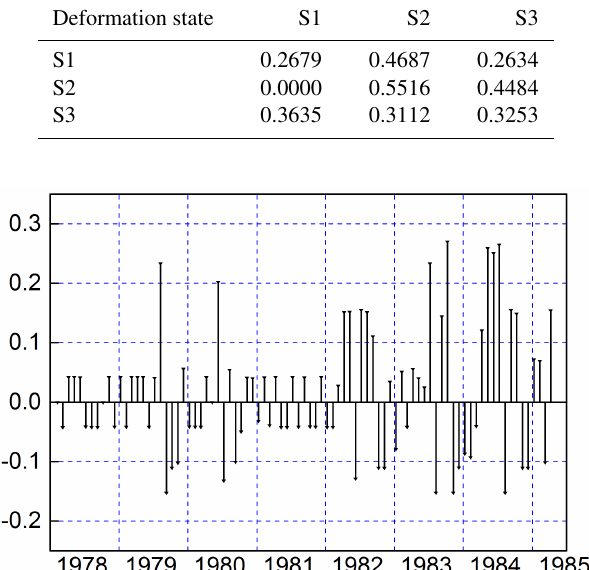
Figure 6. Monthly state fusion entropy of Xintan landslide.